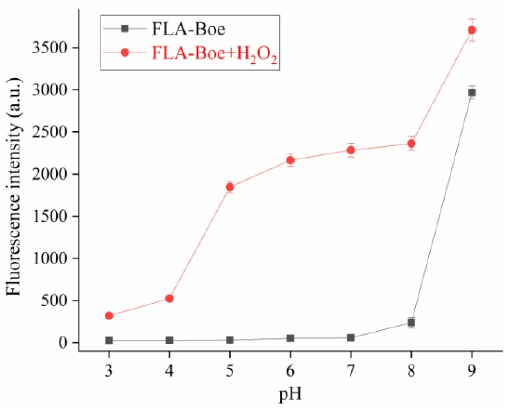
Figure 6. Fluorescence response of FLA-Boe as a function of pH (3.0–9.0) in the absence and presence of H 2 O 2 (DMSO/H 2 O = 1/1, v / v , λ ex = 417 nm).